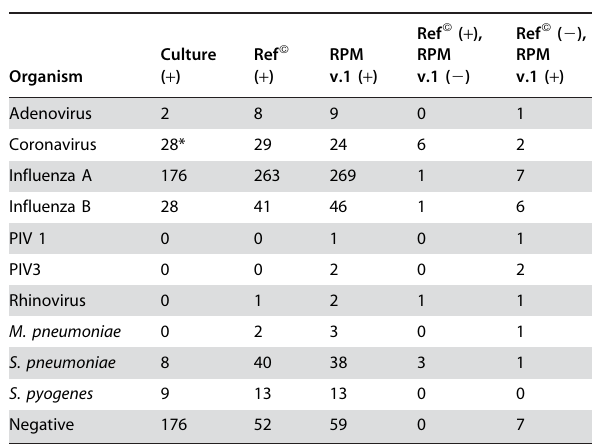
Table 2. Evaluation of the detection efficiency for influenza